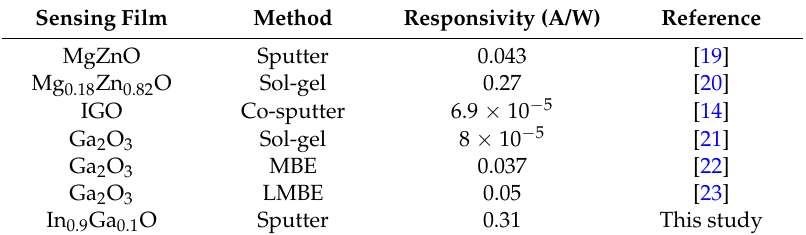
Table 1. Maximum responsivity compared with different MSM ultraviolet photodetectors.